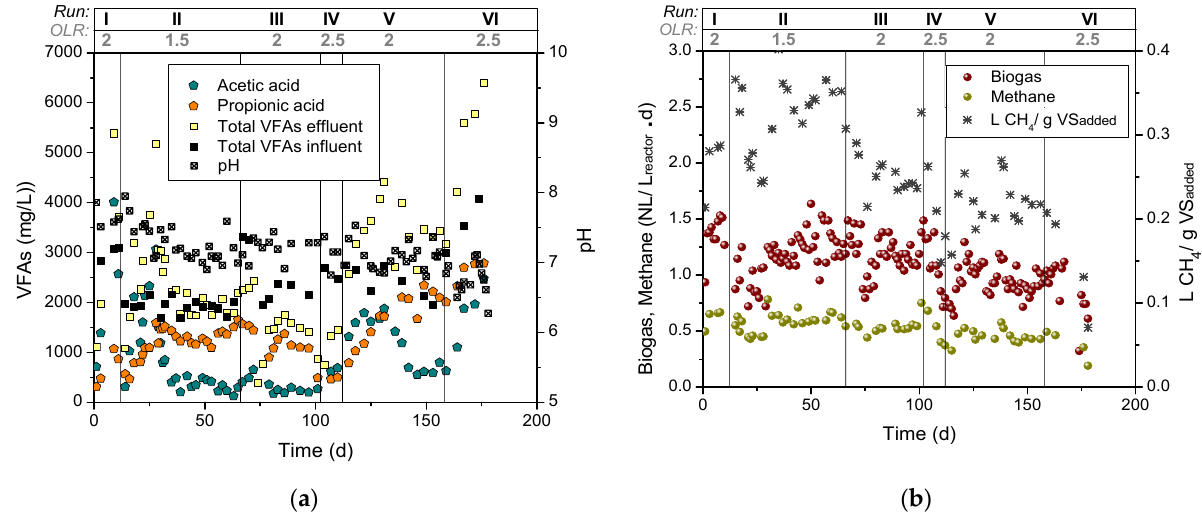
Figure 4. Southern Greece fall/winter scenario: ( a ) Main accumulated VFAs, total VFAs amount of influent and effluent, and pH values, ( b ) biogas and methane yields for all the tested runs.